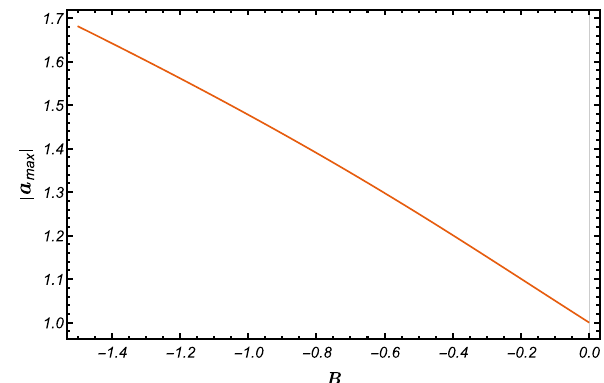
Fig. 2 Variation of maximum possible spin of black hole a max as a function of modified gravity parameter B